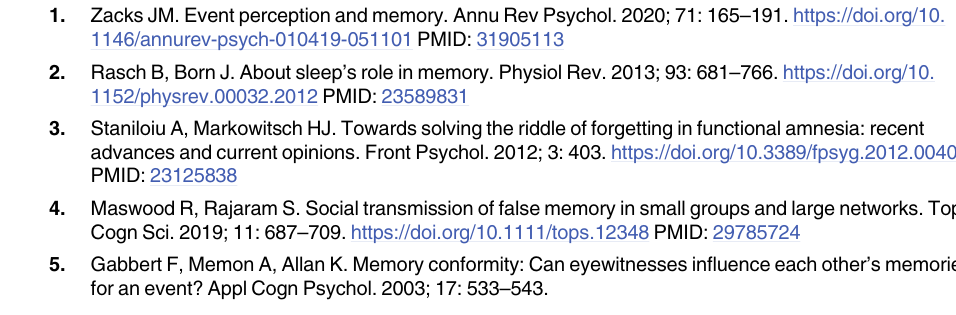
S2 Table. Equations for generating confederate values. A set of three confederate values (C C and C ) for 5 different conditions were generated for each of the following ranges of initial 2 3 response (R ) based on the following equations. x1, x2 and x3 were noise within ± 10 randomly 0 generated by computer and added for reducing conspicuity felt by the participants. A particu- lar condition was then randomly chosen by computer based on the participant’s R ular test video with the probabilities listed below. S3 Table. Demographic information. Total number of participants =